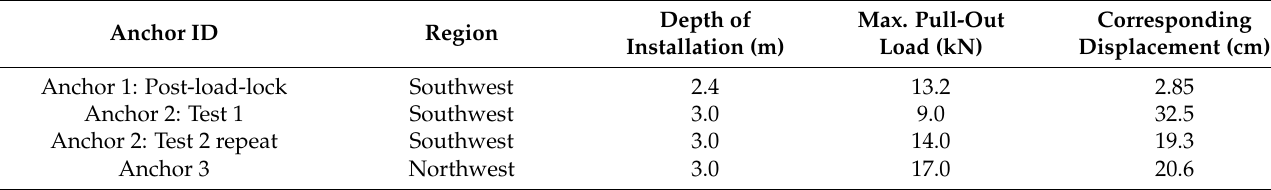
Table 2. Summary of field anchor pull-out test.